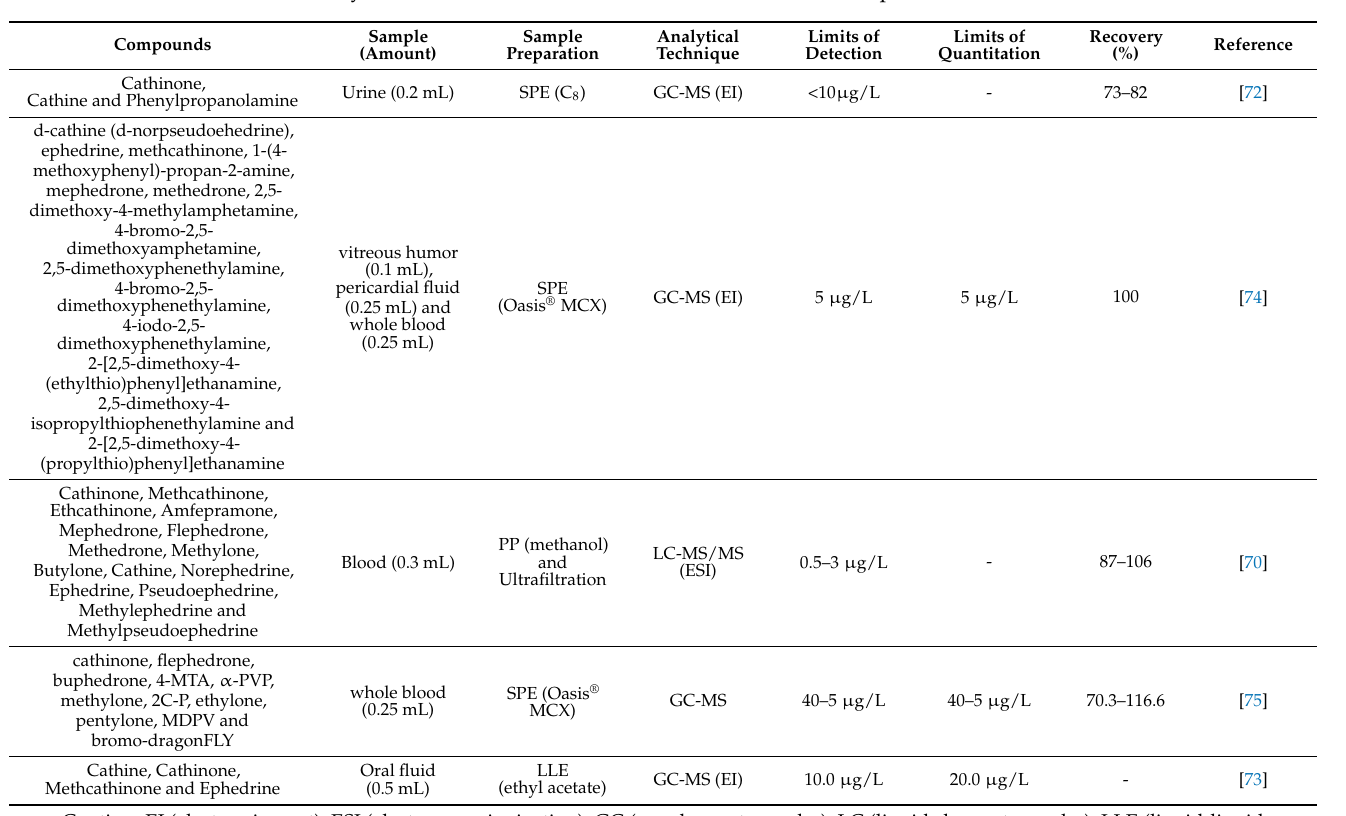
Table 3. Analytical methods for the determination of the main components of Catha edulis